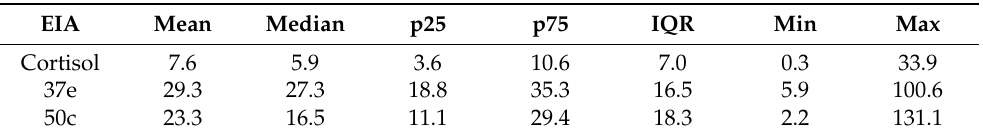
Table 2. Summary statistics for FCM (faecal cortisol metabolite) levels (ng/g) measured by cortisol, 37e and 50c EIAs (enzyme immunoassays).